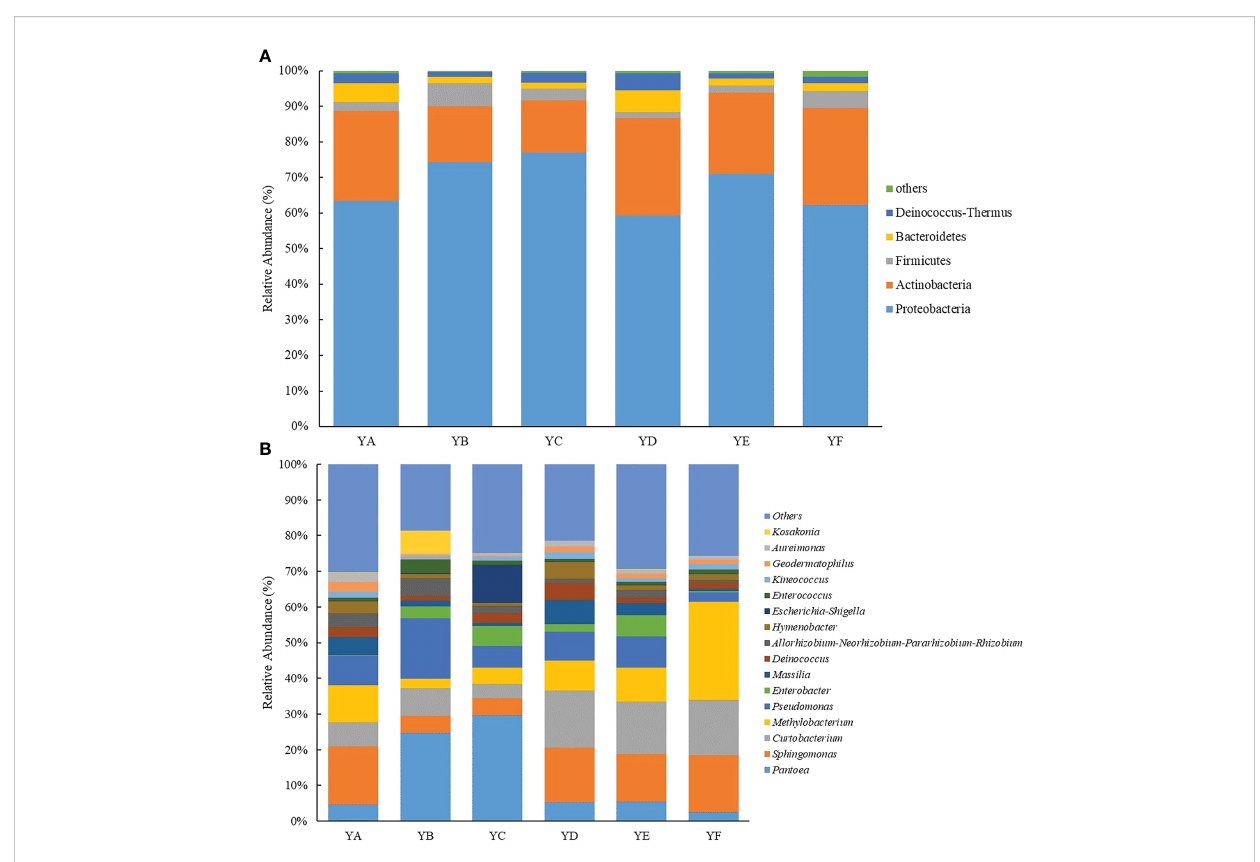
FIGURE 5 Analysis of the composition of phyllosphere bacterial communities in different Populus spp. at all levels of taxonomic units. (A) at the phylum level; (B) at the genus level; YA: Populus x euramaricana 'Bofeng 3 hao'; YB: P. deltoides 'Shanghaiguan' P. deltides 'Harvard'; YC: P. nigra 'N46'; YD: P. nigra 'N102'; YE: P. x euramericana 'Guariento: YF: P. alba × P. glandulosa '84k'.